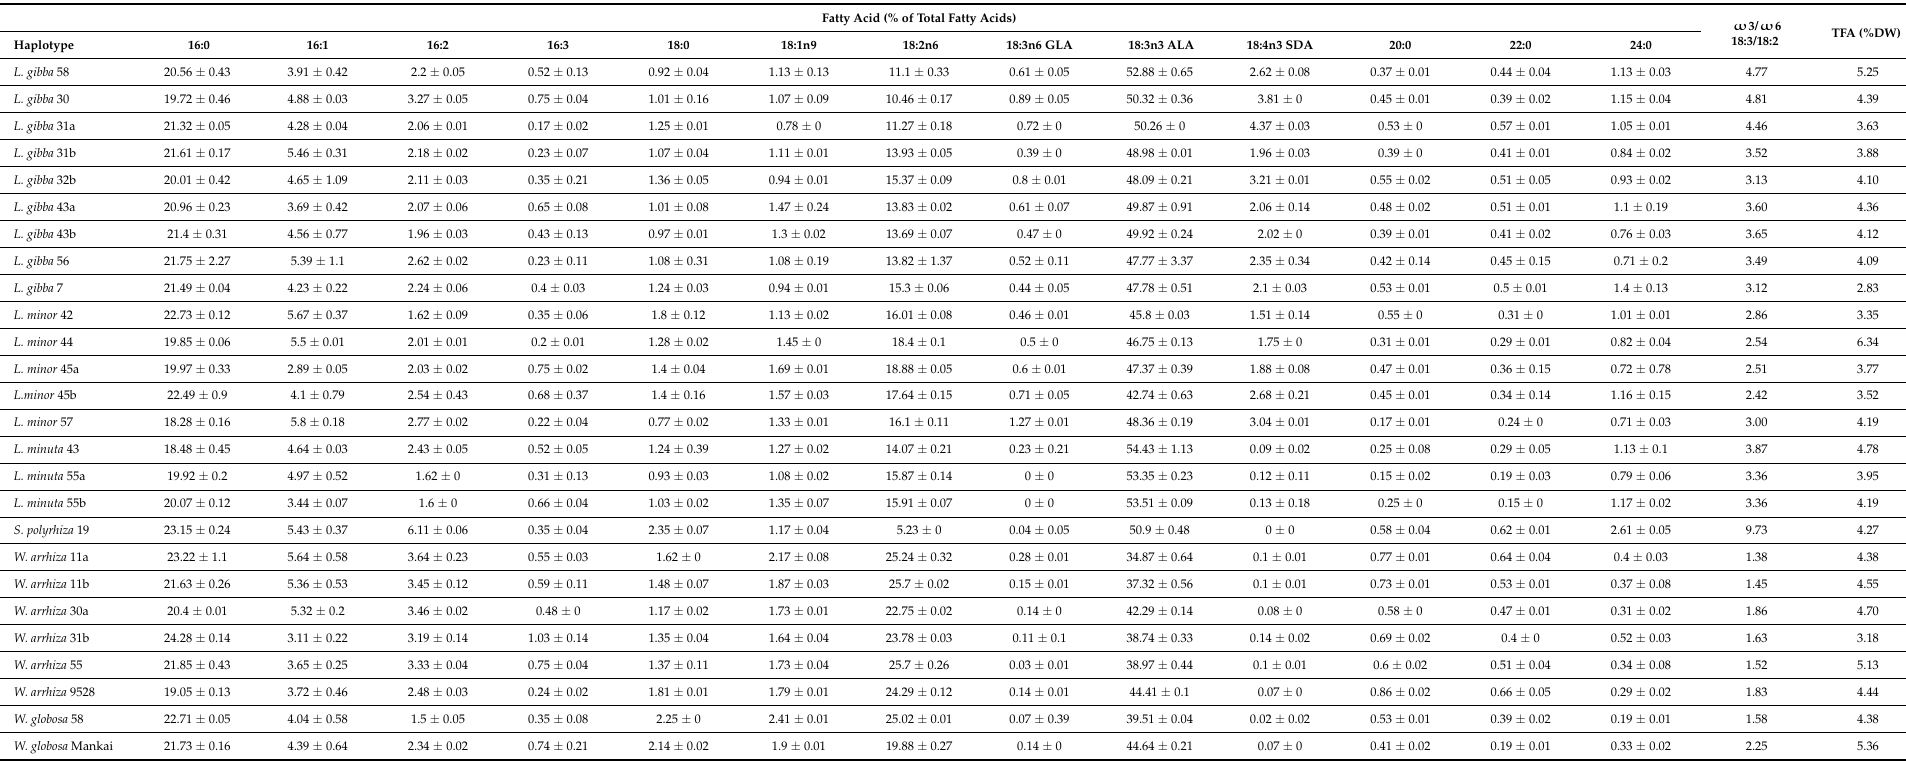
Table 3. Fatty acid composition and content of duckweed plants collected in the current study. The strain W. arrhiza 9528 was added to the analysis as a reference. An isomer of 16:1 and 18:1 n 7 are not shown. The full table is shown in the Supplementary Data (Table